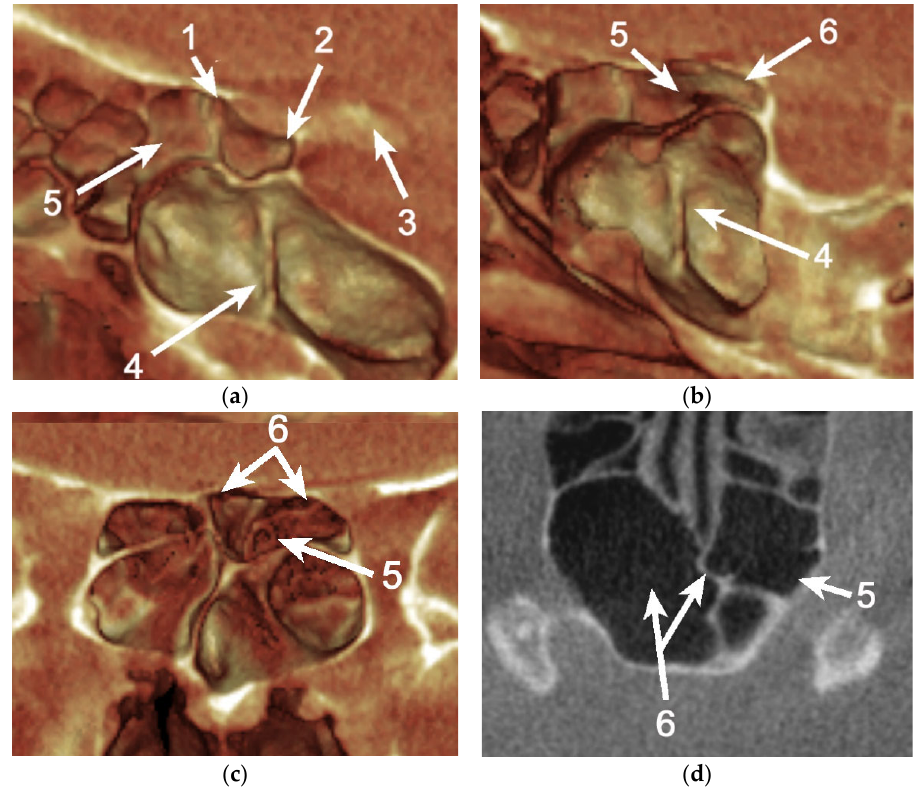
Figure 5. ( a ) Sagittal three-dimensional volume rendering (3DVR) of the anterior clinoid process (ACP) and paranasal air cells on the right side, which demonstrates a distinctive pneumatization of both the optic strut (OS) and anterior root (AR) of the lesser sphenoid wing, including the Onodi cell (ONC) as the origin of pneumatic cells. ( b ) Sagittal 3DVR of the ACP and paranasal air cells on the left side that demonstrates a pneumatization of the OS, including the ONC as the origin of pneumatic cells. ( c ) Coronal 3DVR of the ACP and paranasal air cells; the posterior view demonstrates a bilateral pneumatization of the planum sphenoidale (PS), with ONC as the origin. ( d ) Axial CBCT reconstruction at the level of the pneumatized OS. 1. Pneumatized AR; 2. Pneumatized OS; 3. ACP; 4. Sphenoid sinus; 5. ONC. 6. Pneumatized PS. Table 4. Literature review of the anterior clinoid process (ACP), optic strut (OS), and simultaneous OS and anterior root of the lesser sphenoidal wing (LSW) pneumatization.